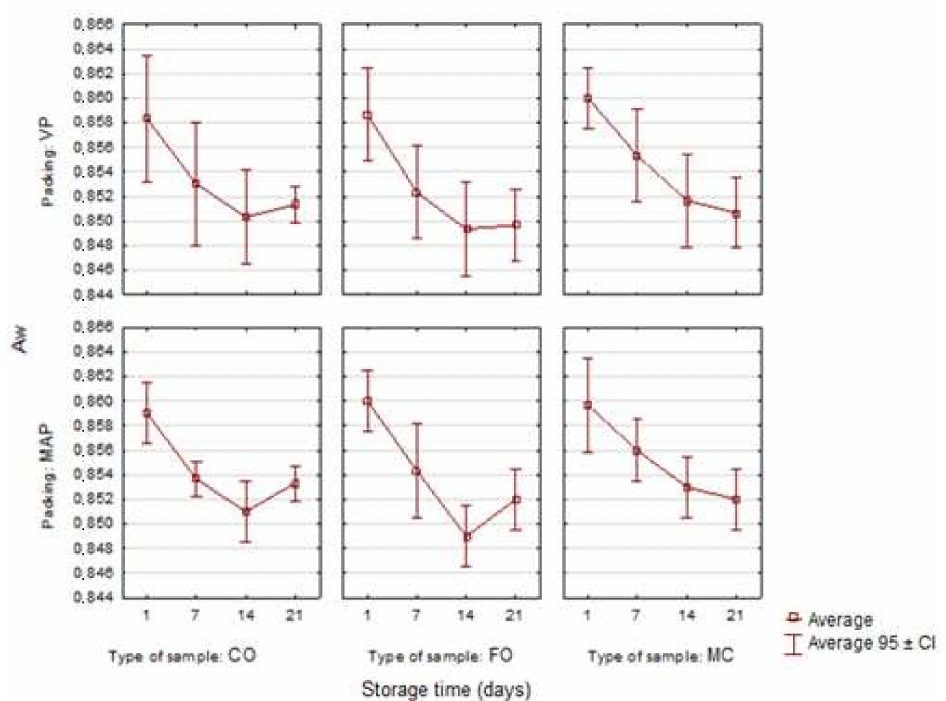
Figure 2. Changes in the water activity (A w ) in the poultry sausages depending on the type of sample, packing and storage time ( n =